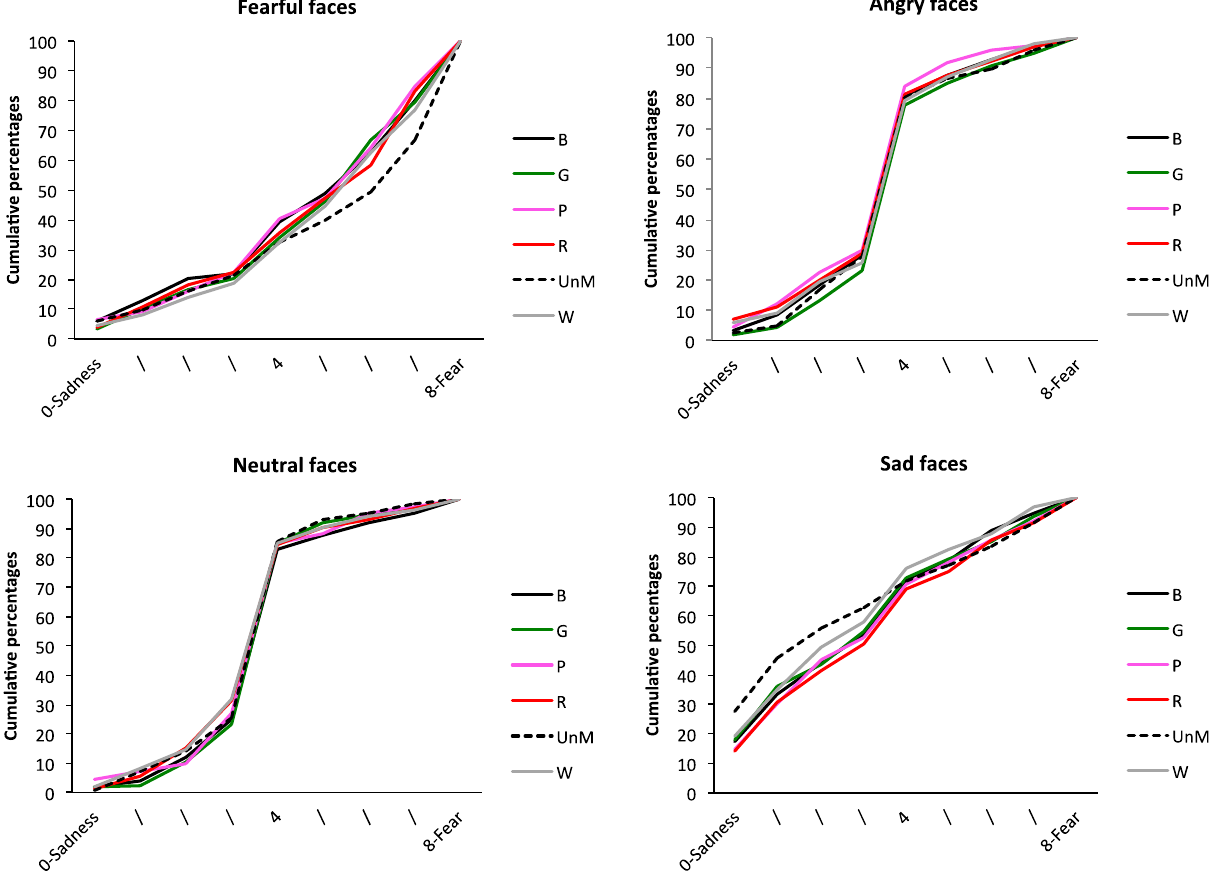
Figure 7. Cumulative percentages of the perception of each EFE for Scale 3, as a function of mask condition (faces wearing a B black, G green, P pink, R red, W white, mask ; UnM unmasked